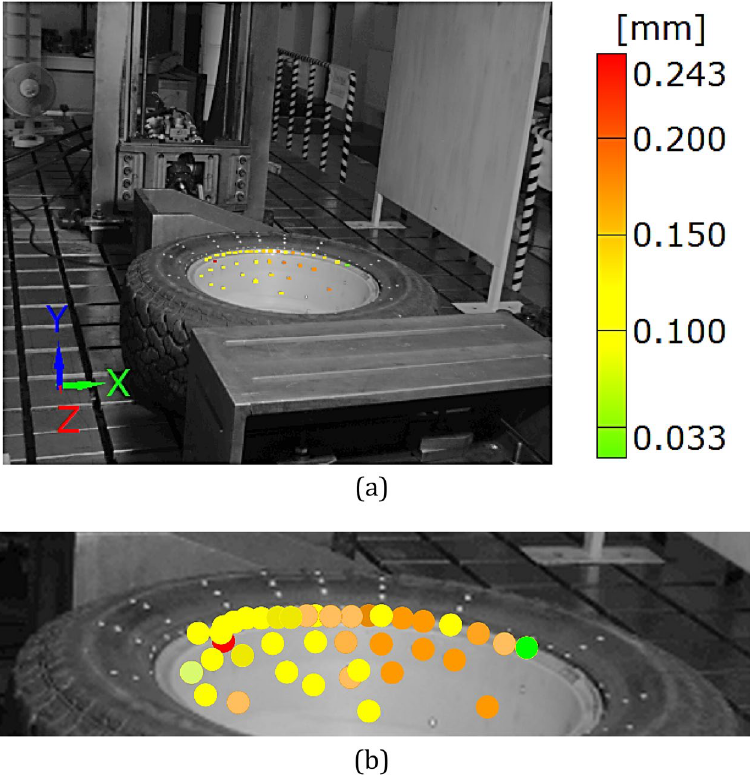
Figure 17. Distribution of the resultant vectors of deflection for the SUV rim after unloading: ( a ) general view, ( b ) magnified view of the